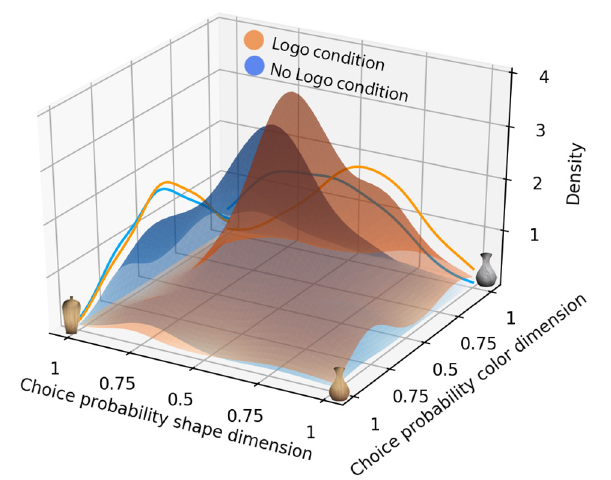
FIGURE 4 | Gaussian densities of participants’ predictions in Block 1. The estimated Gaussian density functions represent the bivariate (combined color and shape) prediction distributions for all agents and all participants for the No Logo condition (blue) and Logo condition (orange) of Block 1. The curves on the left and right walls depict the univariate distributions for the color and shape dimensions, respectively. Notice the higher peak in the bivariate Gaussians for the Logo condition relative to the No Logo condition.